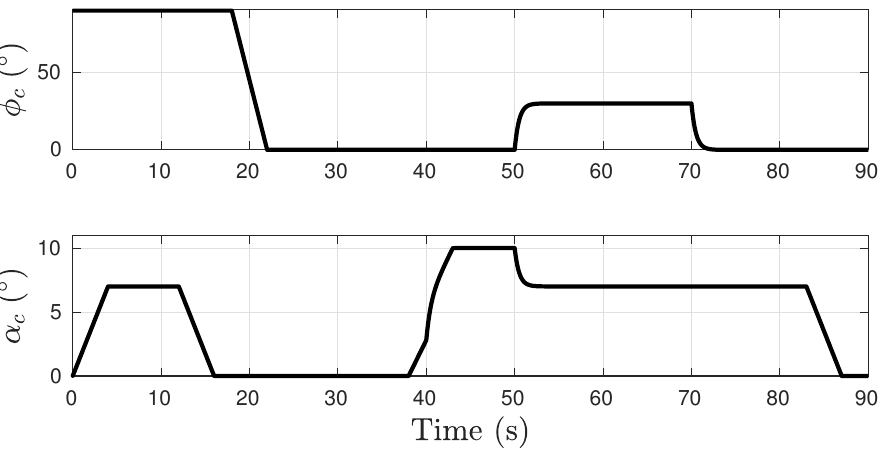
Figure 11. Modified guidance commands for a fly-back booster during